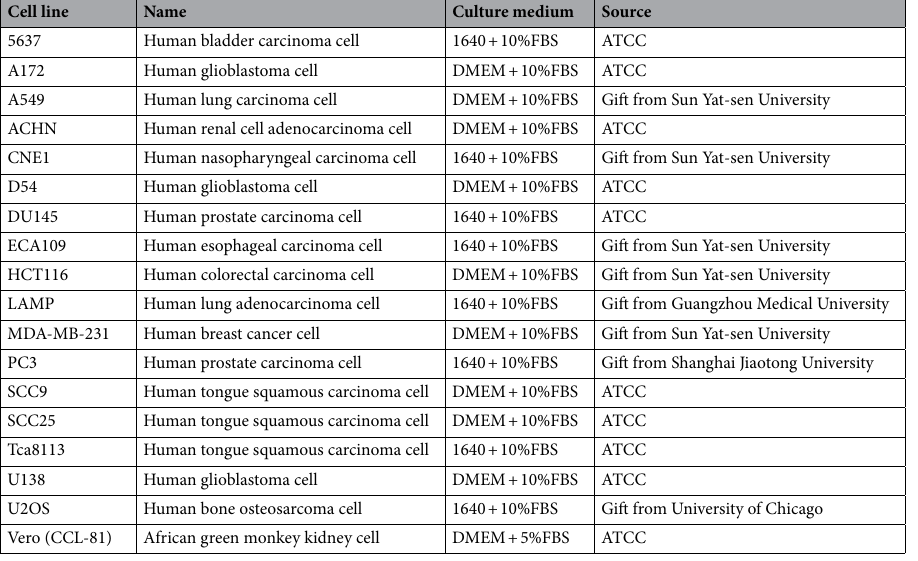
Table 2. Cell lines used in this